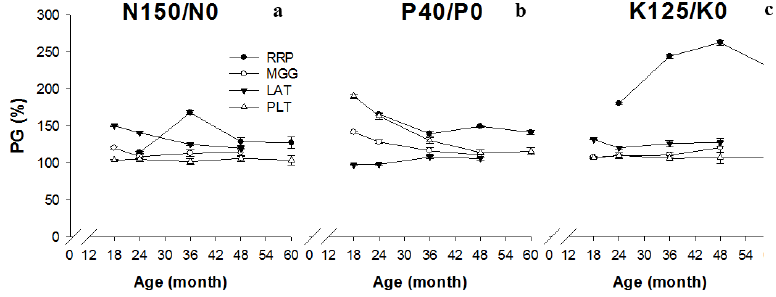
Figure 5. Productivity gains (PG) for N ( a ), P ( b ) and K ( c ) fertilizer applications at different ages in Eucalyptus sp . at four sites. Table 3. Regression equations for N, P and K applied (kg·ha −1 ) according to the age and site in stands of E. grandis × urophylla (PLT and RRP) and E. urophylla × globulus (MGG and LAT).